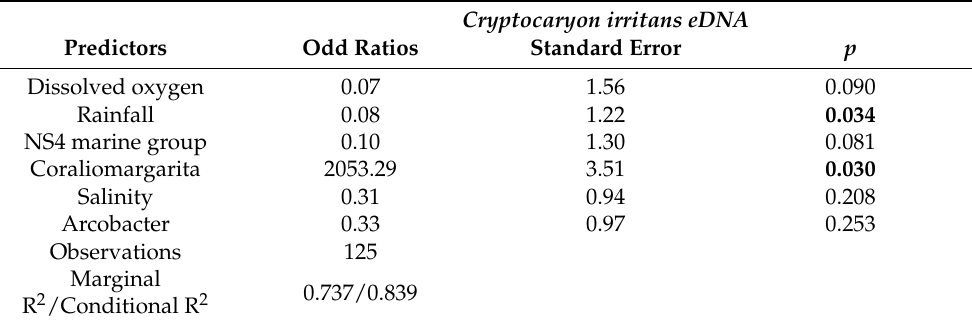
Figure 3. Seasonal changes in the abundance of Cryptocaryon irritans (eDNA) in relation to physical-chemical and en- vironmental parameters: dissolved oxygen (DO), temperature (Temp), rainfall, and salinity for five fish sea cages from Hong Kong between January and August 2020. Table 2. Statistical summary for the logistic regression with mixed effects model on high vs. low Cryptocaryon irritans load based on bacterial microbiome taxonomy (genus level), environmental parameters from a sea cage fish farm in Hong Kong. Terms bolded indicate significant terms ( p <